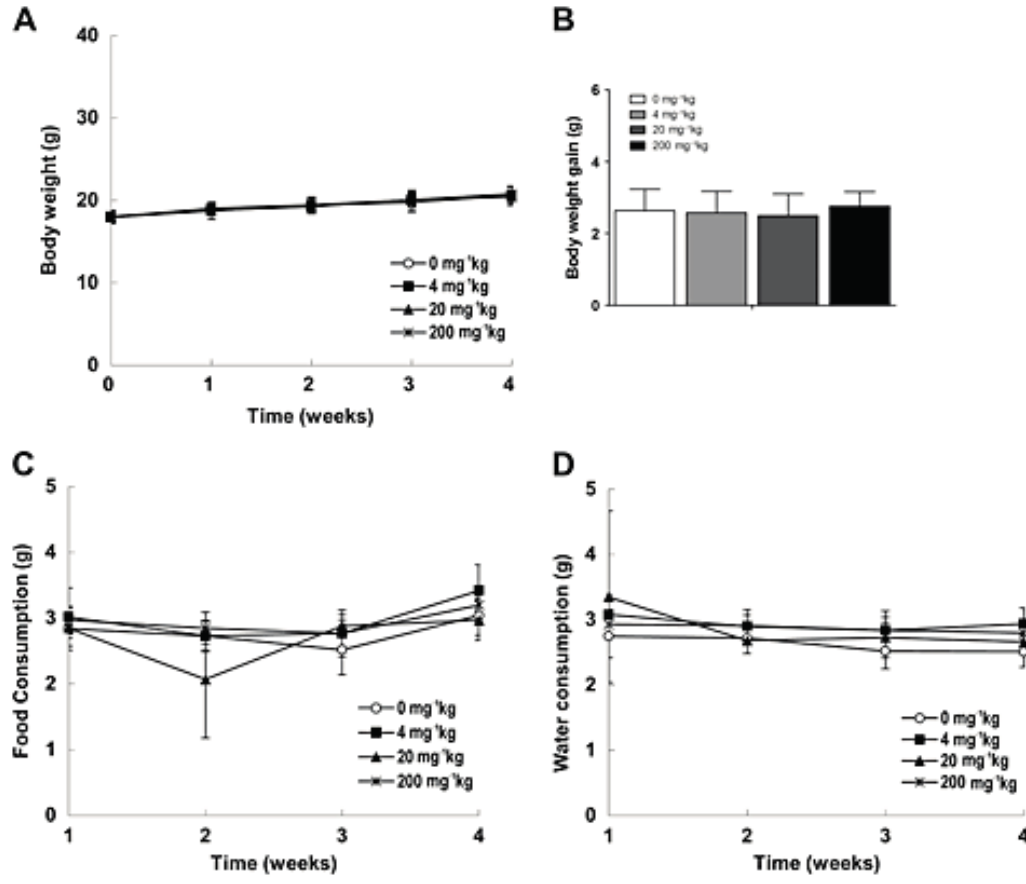
Figure 3. Body weight ( A ), body weight gain ( B ), food ( C ), and water ( D ) consumption in mice injected with core-shell NPs (CSNPs) for four weeks. Reproduced with permission from [42]. Copyright 2015, John Wiley & Sons,